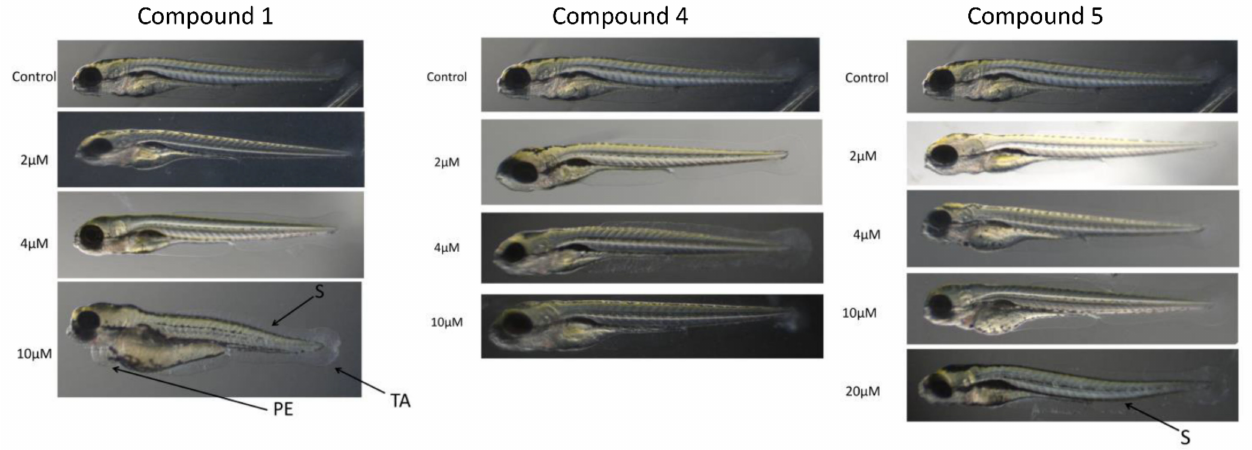
Figure 4. Toxicity of selected compounds on zebrafish ( Danio rerio ) larvae. Fish larvae were grown in 6-well plates in the presence of compounds for up to 5 days and the morphological deformities were analyzed from images as described under Materials and Methods. Representative photographs are shown. S, scoliosis; TA, tail autophagy; PE, pericardial edema.